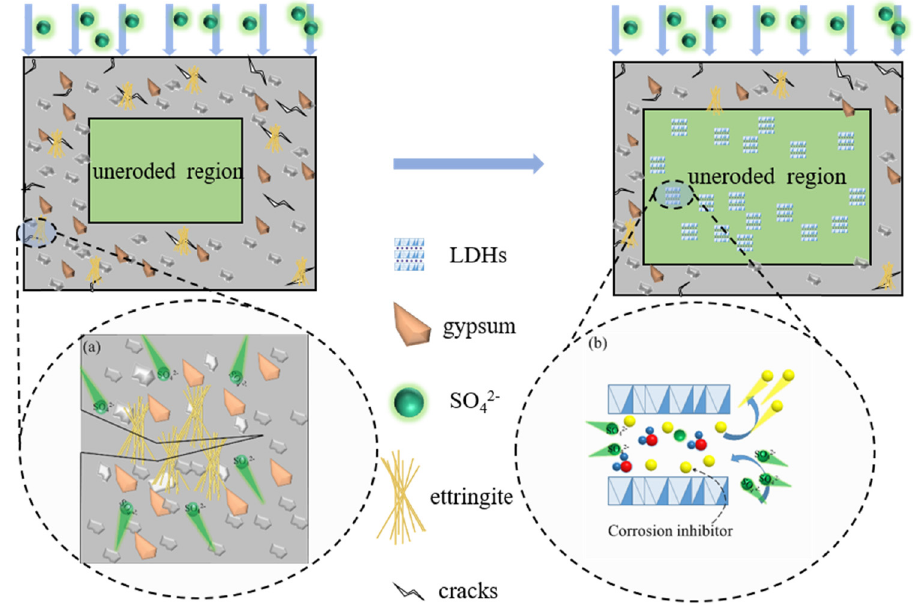
Figure 3: The schematic illustration of sulfate attack induced crack and the modi fi cation of LDHs in concrete: ( a ) the schematic illustration of crack induced by sulfate attack; ( b ) modi fi cation mechanism of LDH on